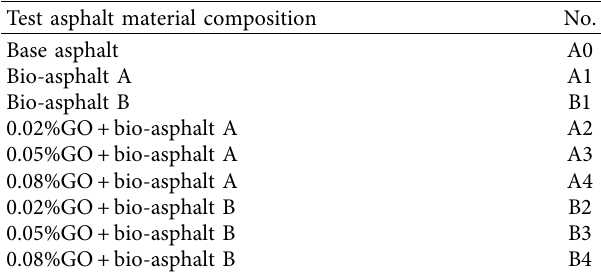
Figure 3: Diagram of the bio-asphalt preparation process. Table 4: Code abbreviation of the test